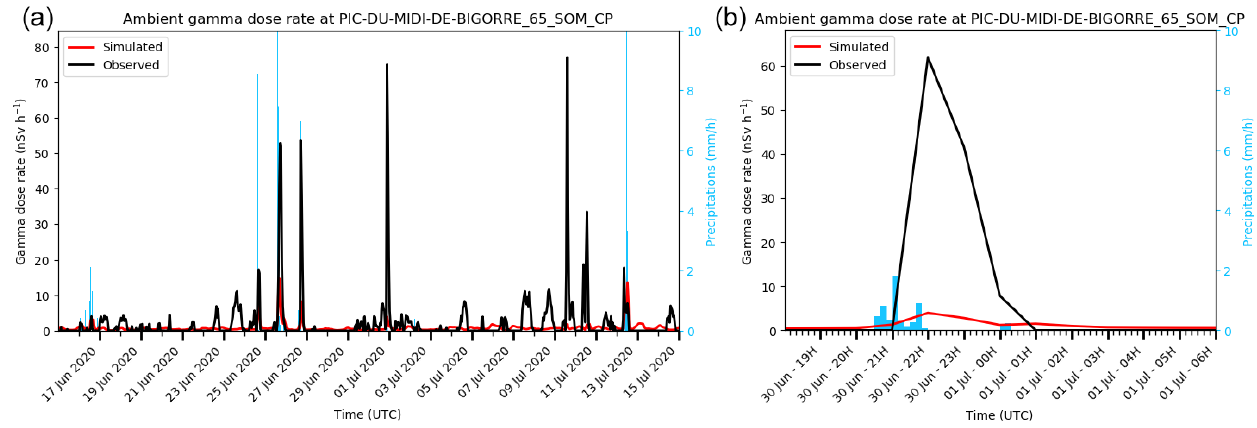
Figure 8. Observed and simulated ambient gamma dose rate at the Pic-du-Midi-de-Bigorre station. (a) In June and July 2020. (b) The